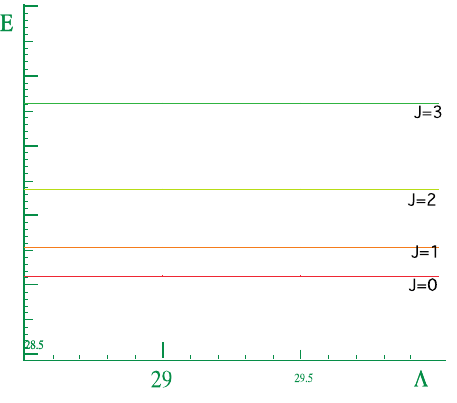
Figure 17. Rotor spectrum for a coupled rotor system for K = 0 at the J values shown